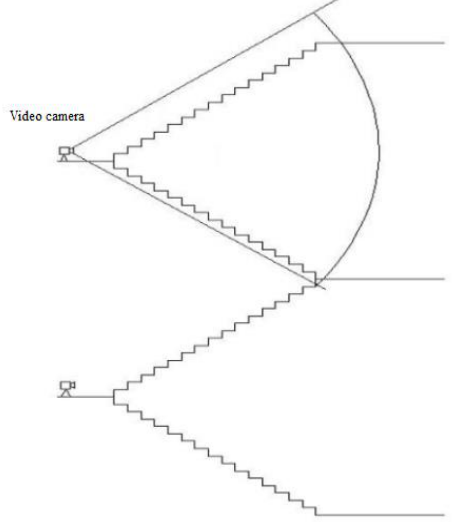
Figure 4. Position of the video camera.